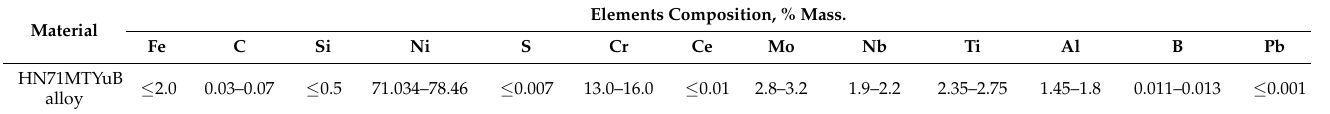
Table 4. The chemical composition of the 12H18N10T steel powder. Elements Composition, % Material